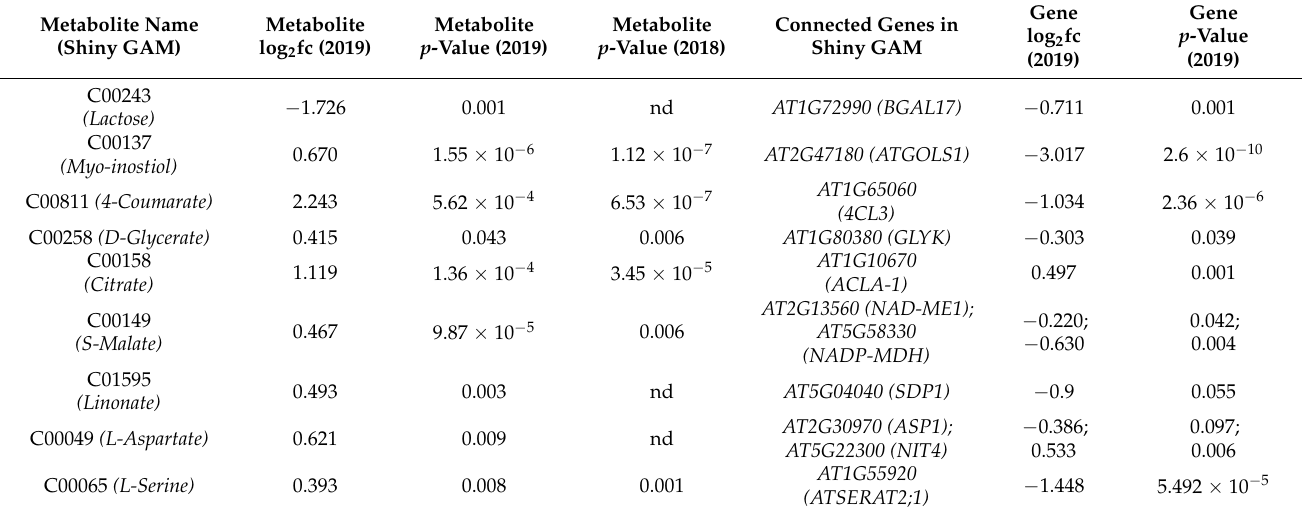
Table 4. Description of significant metabolites-transcripts connection presented in Shiny GAM